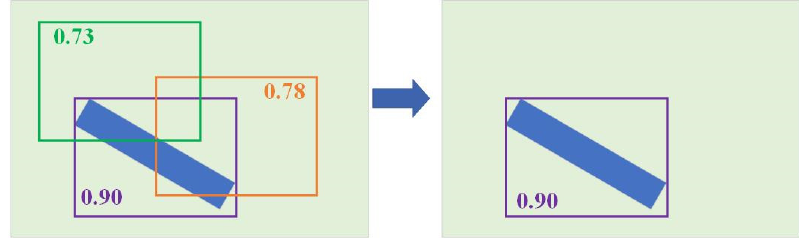
Figure 7. The sketch map of NMS.